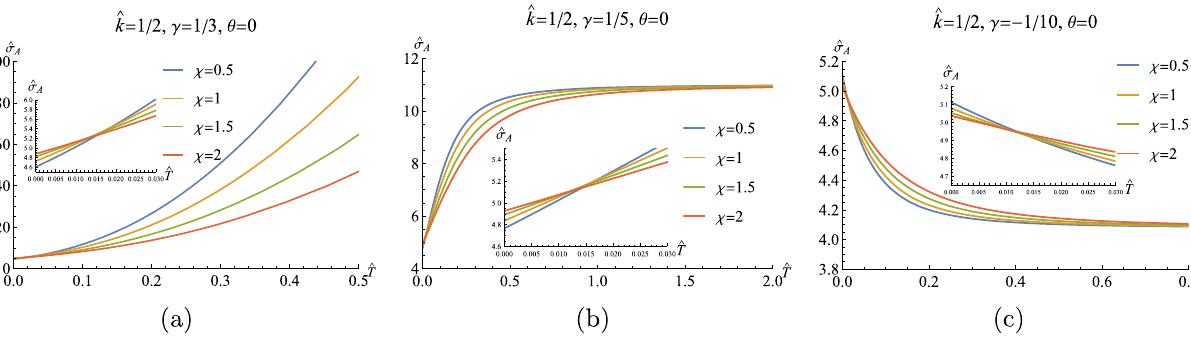
Fig. 3 Electric conductivity ˆ σ A as a function of the temperature ˆ T for various χ values at γ = 1 / 3, 1 / 5 and − 1 / 10. Here, we’ve set ˆ k = 1 / 2 ,θ =